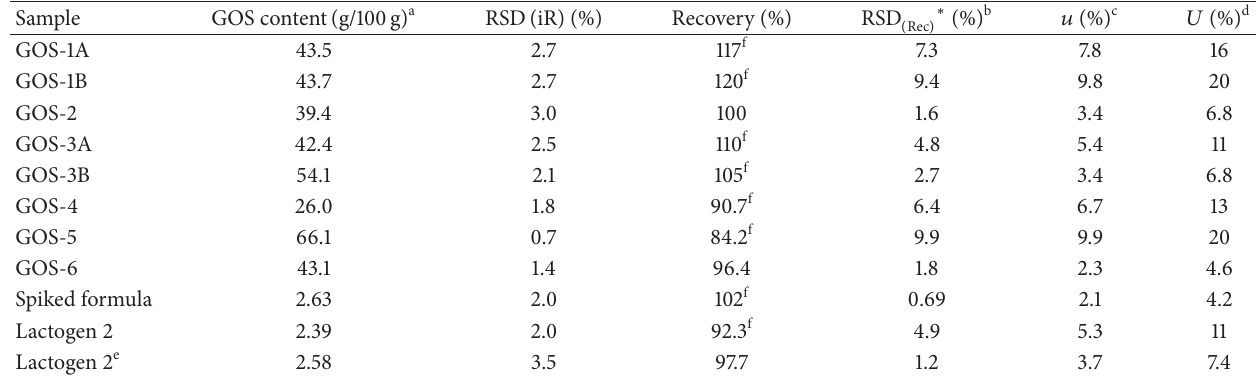
Table 6: Calculation of measurement uncertainty.